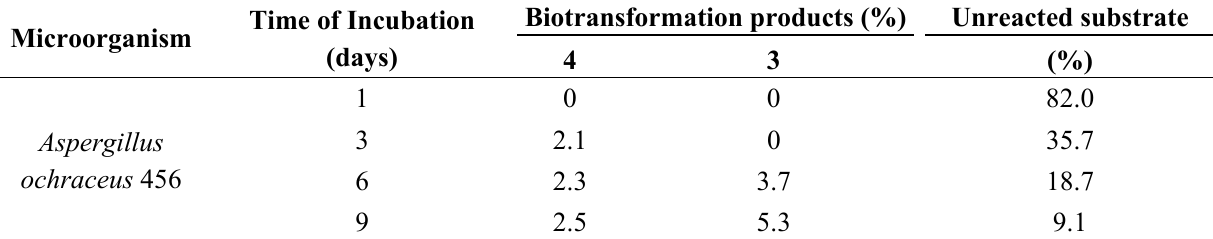
Table 2. Biotransformation of 7-methoxyflavanone ( 1 ), yield (%) of products: 2,4- trans -7- methoxyflavan-4-ol ( 3 ) and 4'-hydroxy-7-methoxyflavone ( 4 ), according to HPLC (screening tests).